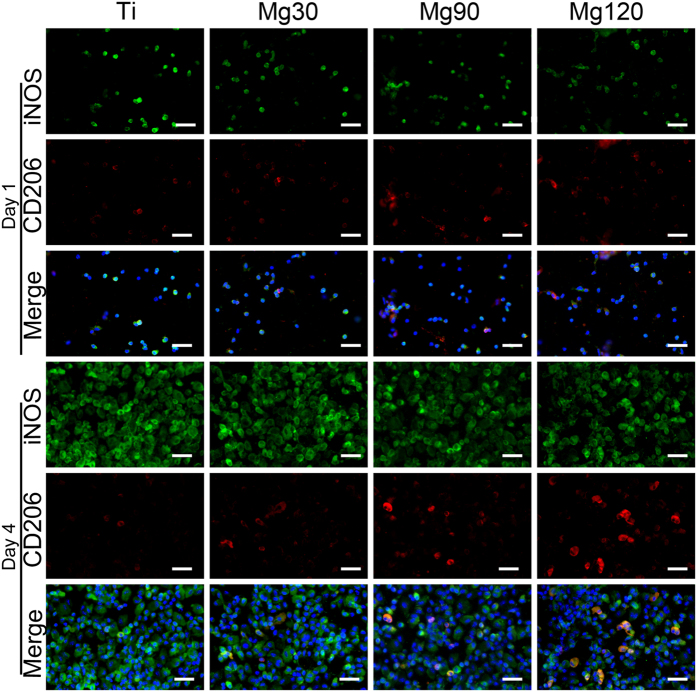
Immunofluorescence images for iNOS (M1 phenotype, in green) and CD206 (M2 phenotype, in red) markers in adherent macrophages on various surfaces 1 and 4 days after surgery; nuclei stained with DAPI (in blue); scale bar: 50 μm.